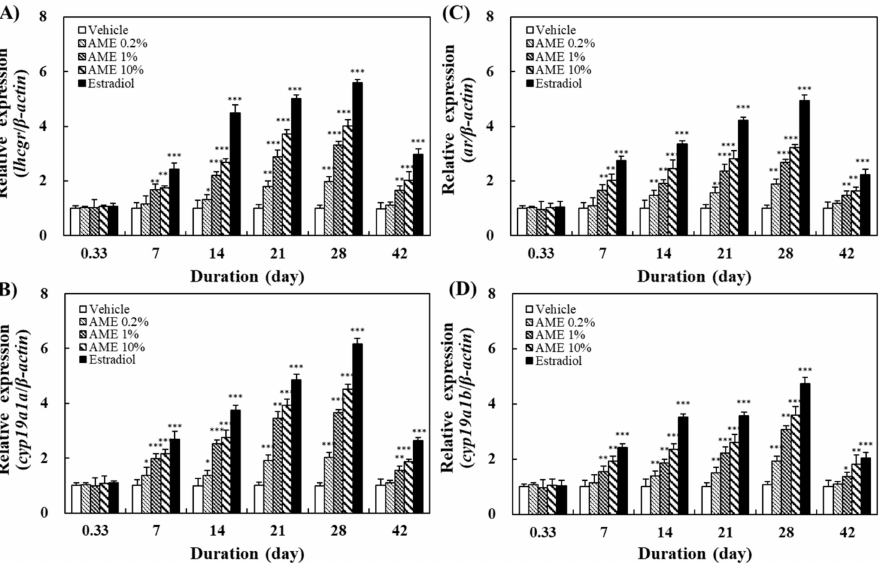
Figure 5. Effects of AME stimulation on the expression of sex-related genes in zebrafish: ( A ) female, lhcgr in ovaries; ( B ) female, cyp19a1a in the brain; ( C ) male, ar in the testes; ( D ) male, cyp19a1b in the brain. Five adult zebrafish were used for each experimental group at each sampling time. Statistical differences in gene expression between the AME-supplemented-diet group and the vehicle group were tested using one-way ANOVA, and levels of significance are denoted as * p < 0.05, ** p < 0.01, and *** p < 0.001.